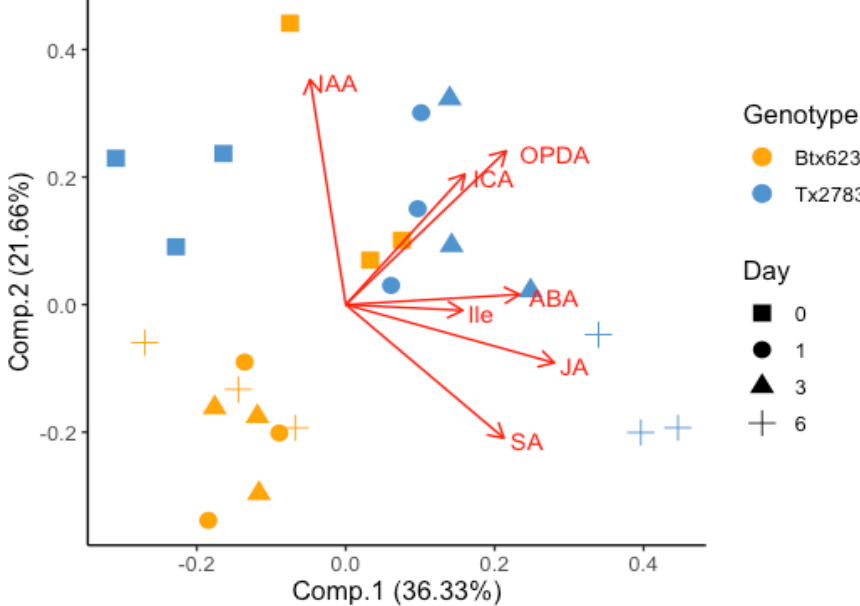
Figure 4. Principal component analysis (PCA) of phytohormones data collected from two sorghum genotypes (Tx2783 and BTx623) at different time points (0-, 1-, 3-, and 6-dpi) infested with sugarcane aphid.